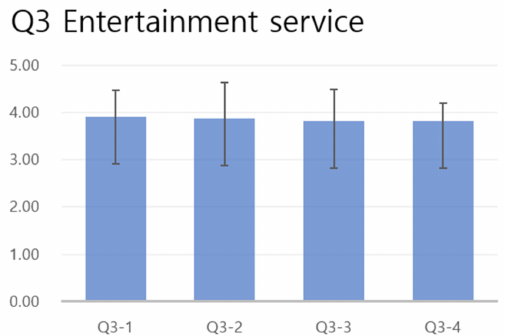
Figure 13. Results showing user service satisfaction with the entertainment